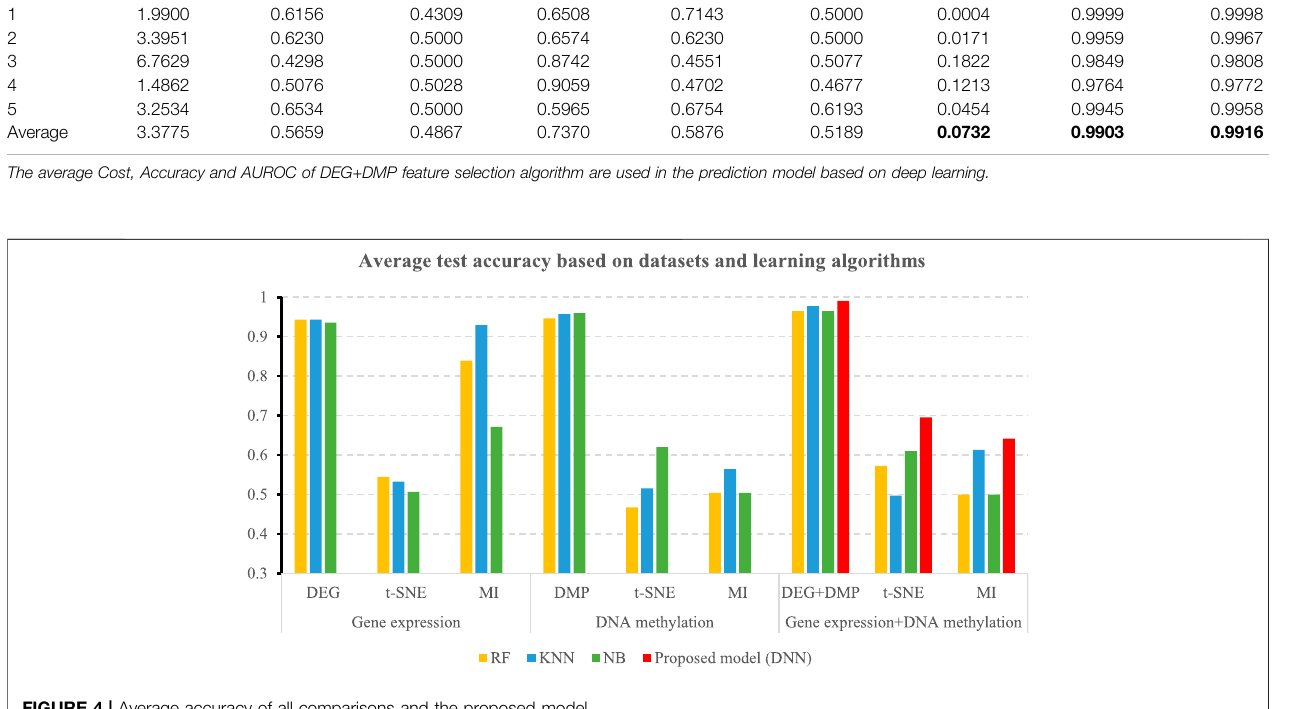
The proposed model